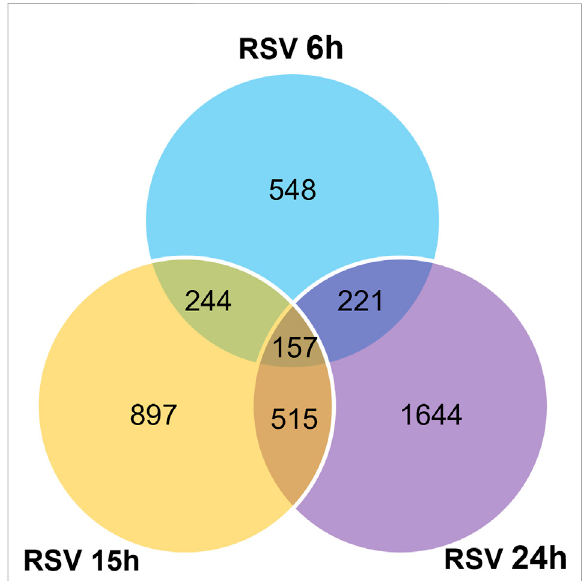
FIGURE 2 Intersecting Venn diagram showing the numbers of up- and down-regulated piRNAs differentially expressed at the three different time points (6, 15 and 24 h) RSV p. i. Compared to the mock (uninfected) SAE cells. The numbers in overlapping area(s) represent the differential regulated number of piRNAs shared among all the time points. Data is representative of six replicates for each time point with p <